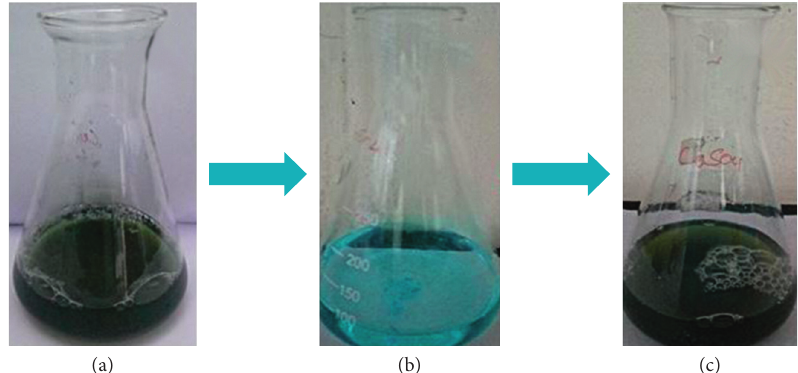
Figure 1: Visual observation of synthesis of copper nanoparticles. (a) Leaf extract, (b) copper sulphate, and (c) final color of CuNPs was obtained after the synthesis process of completion.